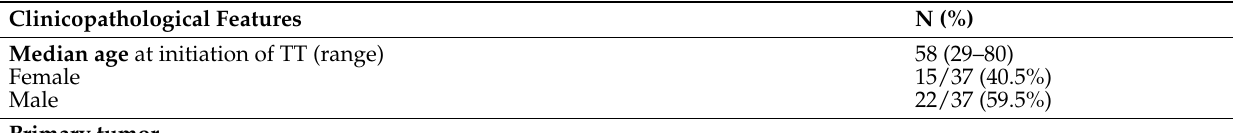
Table 1. Baseline patient